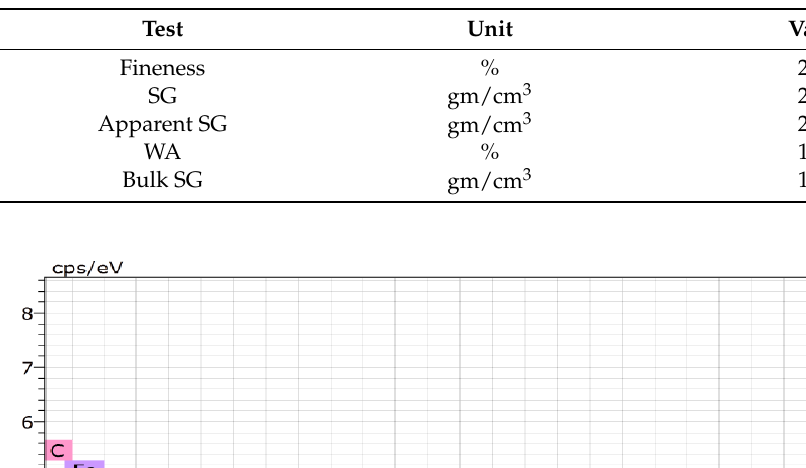
Table 3. Mechanical Characteristics of MP.